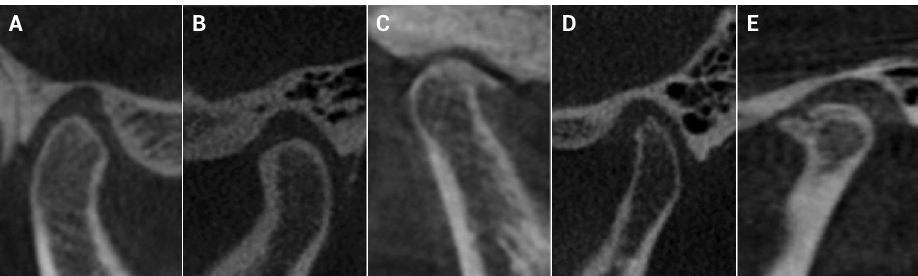
Figure 1. Examples of degenerative bone changes. (A) erosion; (B) sclerosis; (C) flattening; (D) osteophytes; (E) subchondral